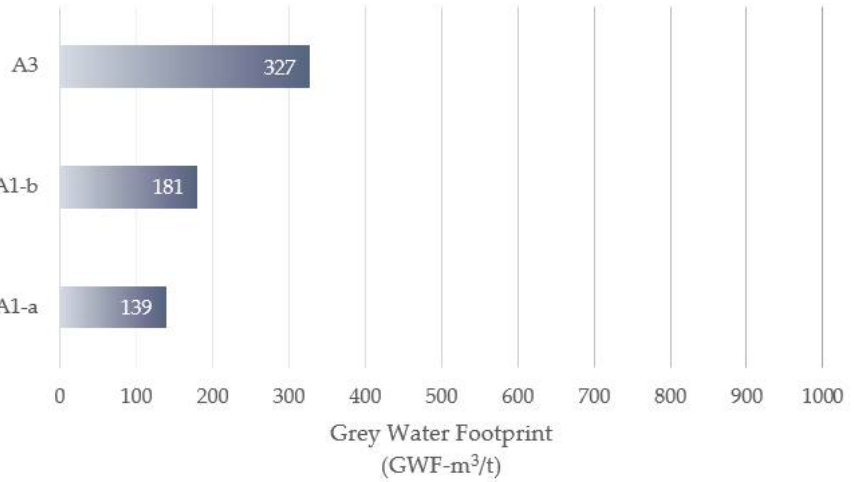
Figure 4. Grey water footprint (GWF) volume in barley crop during 2020 growing period using different calculation approaches. Leaching/runoff fraction approach (A1): A1-a: α = 10%, A1-b: α as a function of weather, soil and crop management factors; and N balance approach (A3). Surplus approach (A2) could not be applied for GWF estimation, because it estimated a negative contaminant load (L = 0).